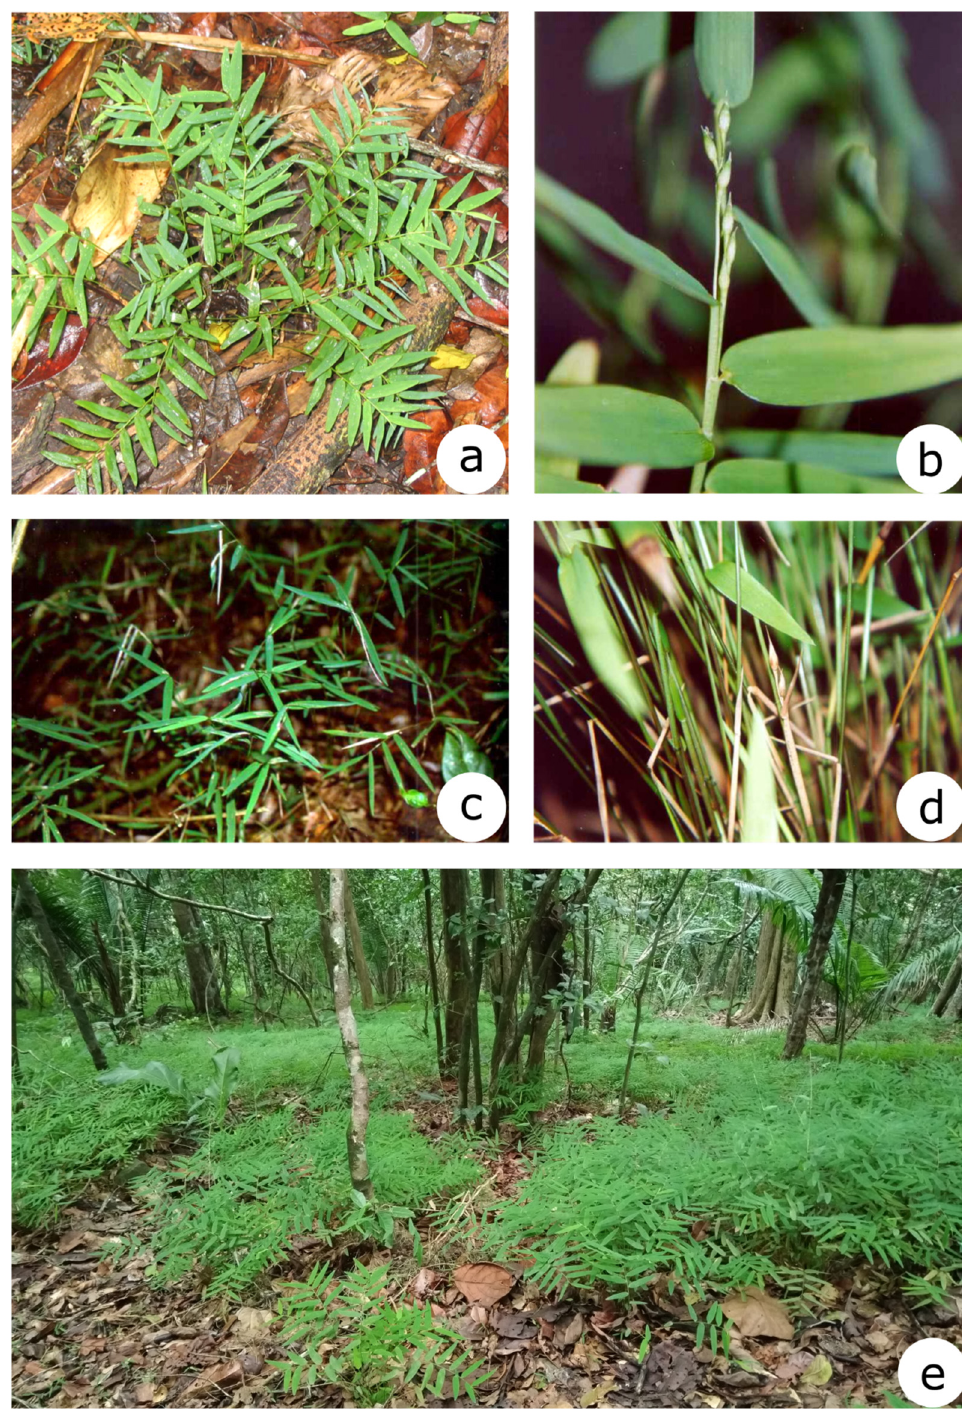
Figure 1. Raddia species: ( a ), Raddia portoi ; ( b ), Inflorescence of R. portoi ; ( c ), R. angustifolia ; ( d ), Inflorescence of R. angustifolia , ( e ) Large population of R. portoi in the city of Cachoeira, Bahia. Low variation in both partitions and therefore the infra-generics relationships are not well resolved, and it was not possible to support them as separate species based on these studies. In turn, posterior studies involving this genus did not include R. portoi or R. angustifolia , but only one or a few accessions of other Raddia species, focusing on the relationships above the genus level